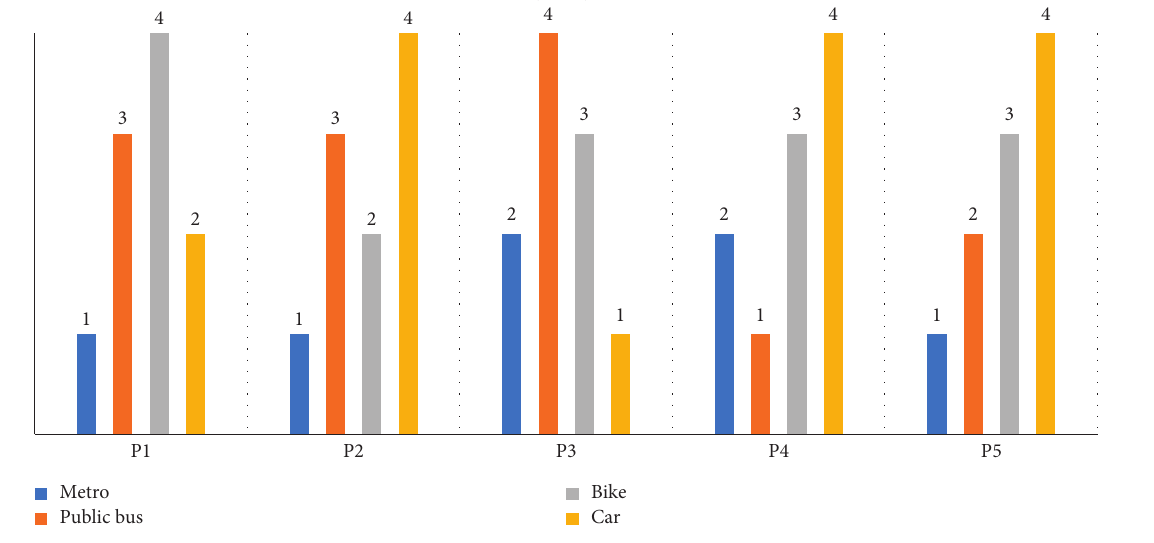
Figure 6: Sensitivity analysis using TOPSIS.